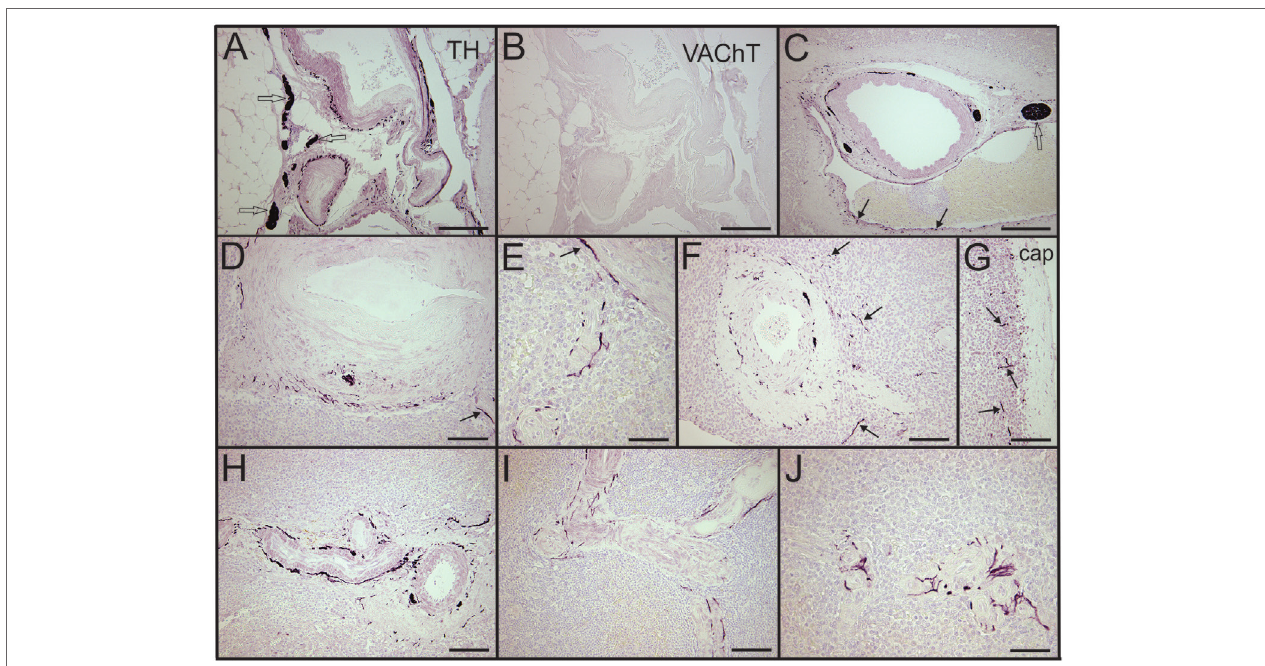
FigUre 1 | Control human spleens had abundant tyrosine hydroxylase (TH) + sympathetic nerves associated with the vasculature and lacked cholinergic innervation. (a,b) Images showing noradrenergic (TH + ) nerve fibers and bundles around splenic artery and branches (a) and absence of cholinergic (VAChT) nerves in an adjacent section (b) from a 74-year-old female. (c) Low magnification image of TH + nerve fibers and bundles around a trabecular artery in a spleen section from a male trauma patient. Arrows indicate TH + nerve fibers around an adjacent large vein. (D,e) TH + fibers associated with central artery and smaller branches in the same 74-year-old female. Nerve fibers are localized to adventitia and adventitia-media border. Arrow in (D) indicates nerve around branch of central artery shown at higher magnification in (e) . (F) Sympathetic nerves around a central artery and branch from another trauma patient. Arrows indicate some TH + nerve fibers that entered the periarterial lymphatic sheath. (g) Same patient had TH + nerve fibers (some indicated by arrows) in lymphatic tissue under the capsule. (h,i) TH + fibers around small, branching arteries in sections from first trauma patient (h) and from a 57-year-old female (i) . (J) Periarteriolar TH + nerve fibers in spleen section from a 74-year-old female. TH + nerve fibers extend a short distance into surrounding lymphatic tissue. Open arrows indicate some TH + nerve bundles. Scale bars: 250 µm (a–c) ; 100 µm (D,F–i) ; 50 µm (e,J)